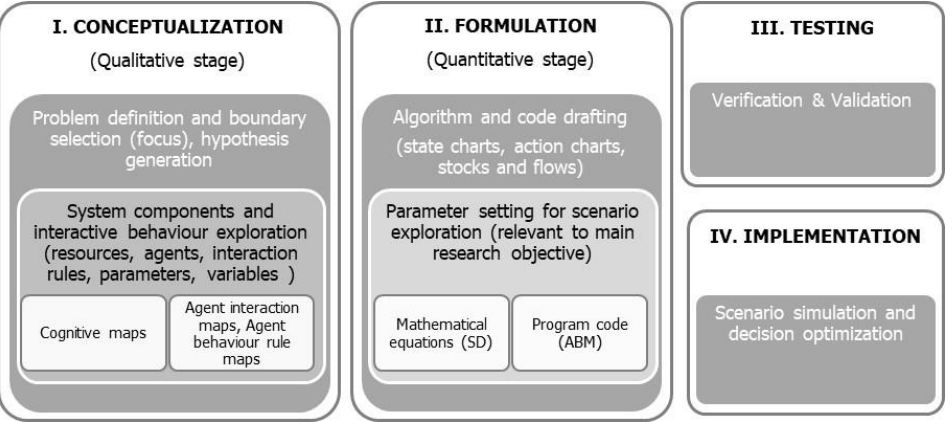
Figure 4. Key stages of the modelling approach in VALUMICS (Authors own conceptualisation previously presented in project deliverable [67]).